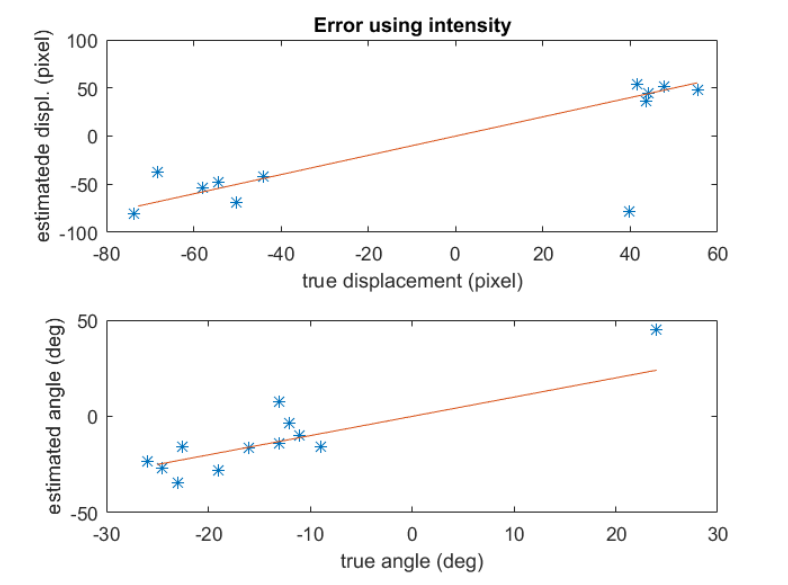
Figure 18. Standard method error